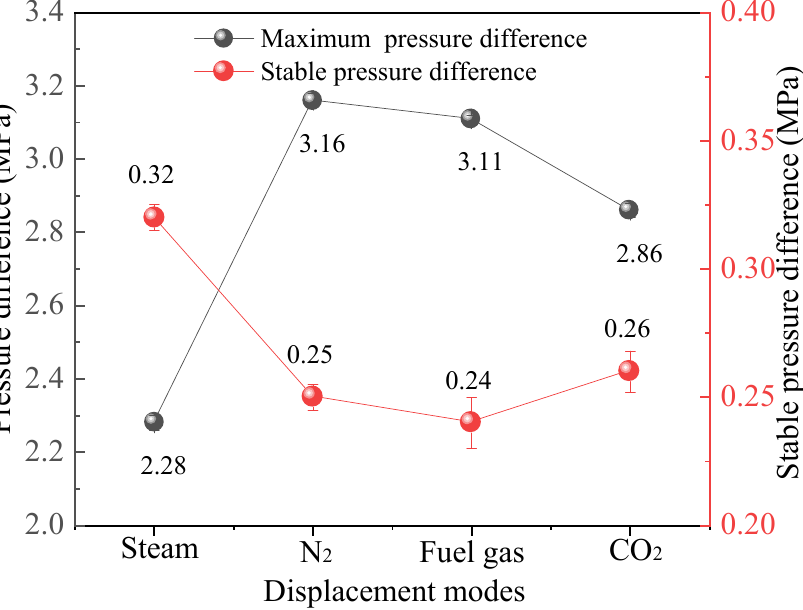
Figure 7. Maximum pressure difference and stable pressure difference under different displacement